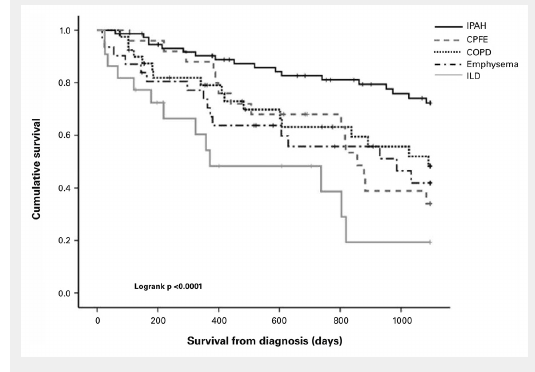
Survival for patients with pulmonary arterial hypertension, pulmonary hypertension associated with CPFE, COPD, emphysema and ILD . Survival for PH-ILD was significantly lower compared with PAH (p <0.0001), PH-COPD (p = 0.0026) and PH- CPFE (p = 0.05), while survival for other lung phenotypes did not differ significantly. CPFE = combined pulmonary fibrosis and emphysema; COPD = chronic obstructive pulmonary disease; ILD = interstitial lung disease; PAH = pulmonary arterial hypertension; PH = pulmonary hypertension. (Reproduced with permission of the European Respiratory Society © Eur Respir J. 2015;46(5):1378–89; DOI: 10.1183/13993003.02307-2014)